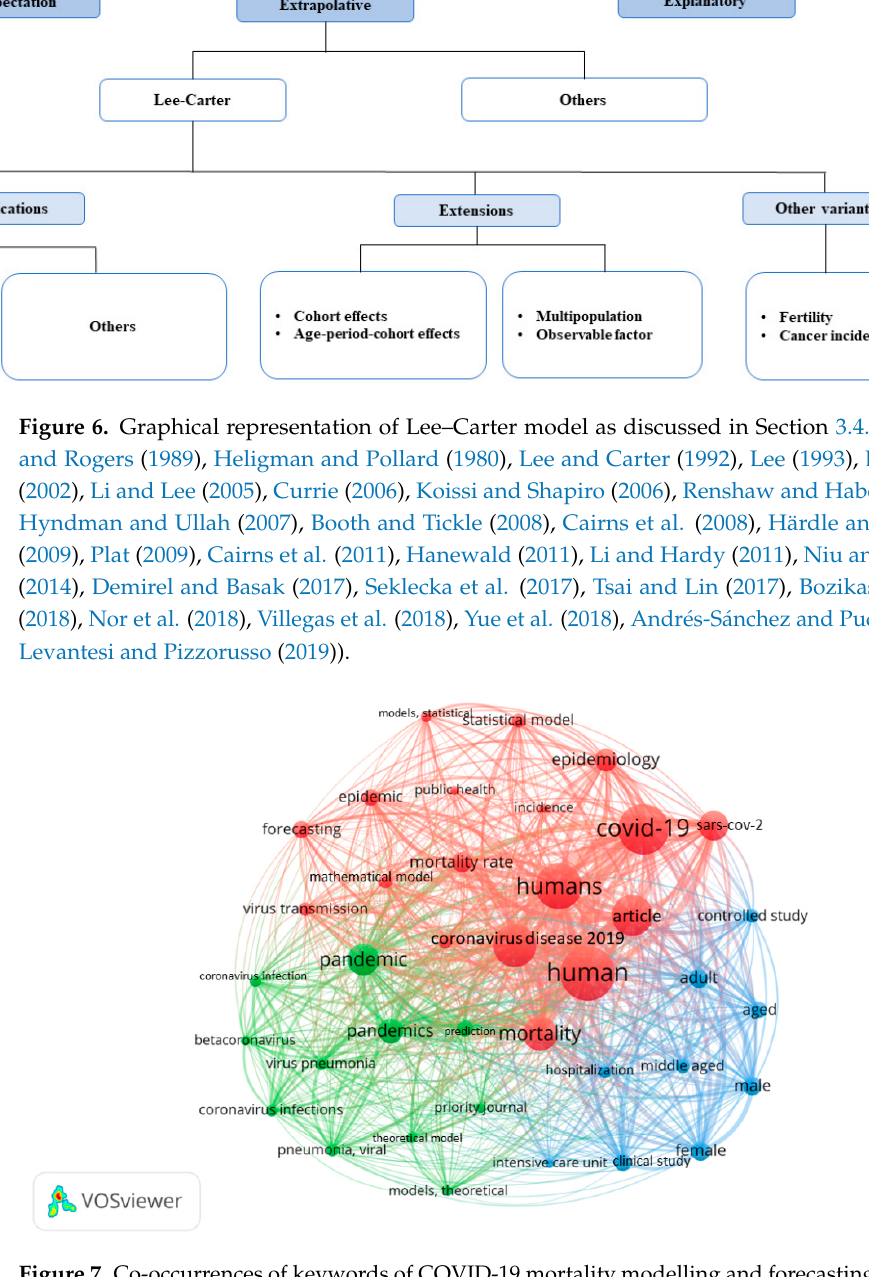
Figure 7. Co-occurrences of keywords of COVID-19 mortality modelling and forecasting publications. Red represents cluster 1, green represents cluster 2 and blue represents cluster 3.